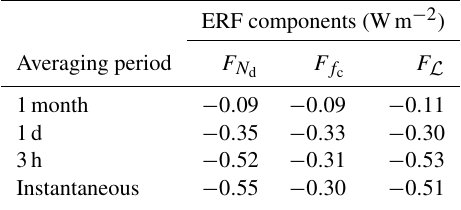
Table 3. Dependence of diagnosed ERF aci components on temporal